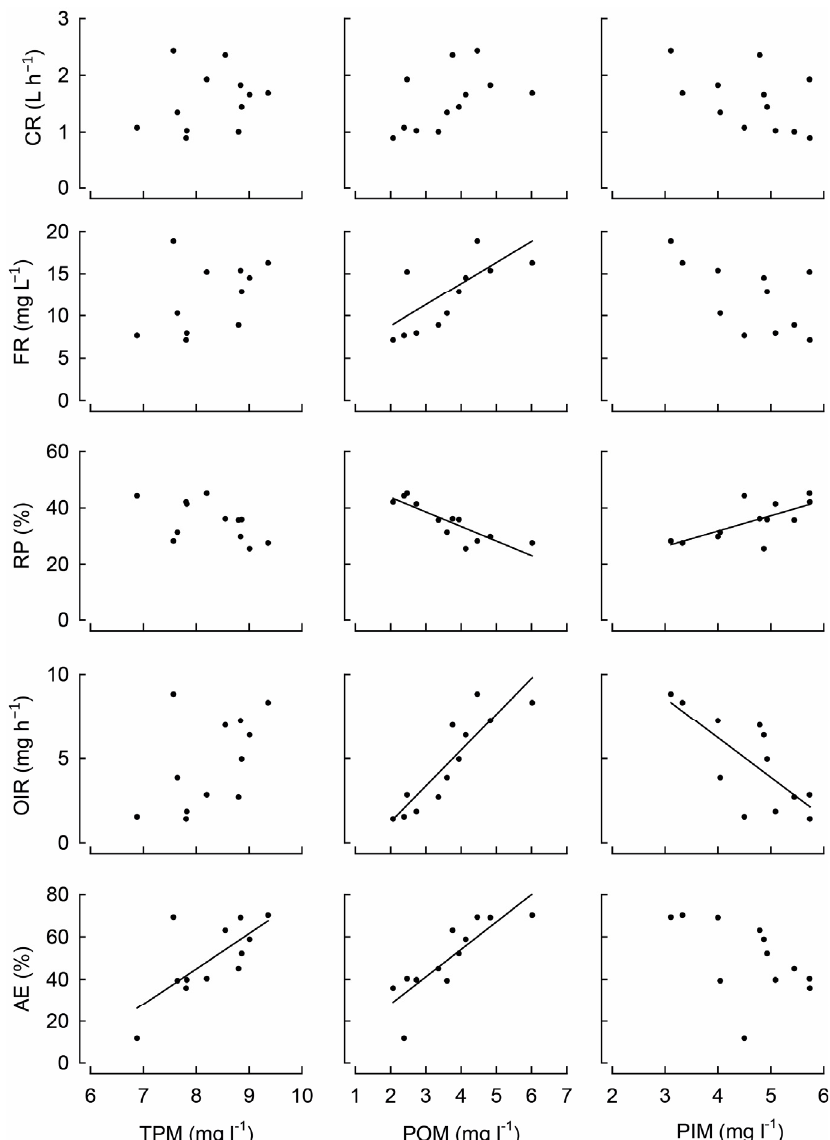
Figure 5. Relationships between Swan-Canning Estuary water parameters and Mytilus galloprovincialis feeding parameters; TPM (total particulate matter), POM (particulate organic matter), PIM (particulate inorganic matter), f (seston quality), and CR (clearance rate), FR (filtration rate), RP (rejection proportion), AE (absorption efficiency), OIR (organic ingestion rate). Lines represent significant relationships.